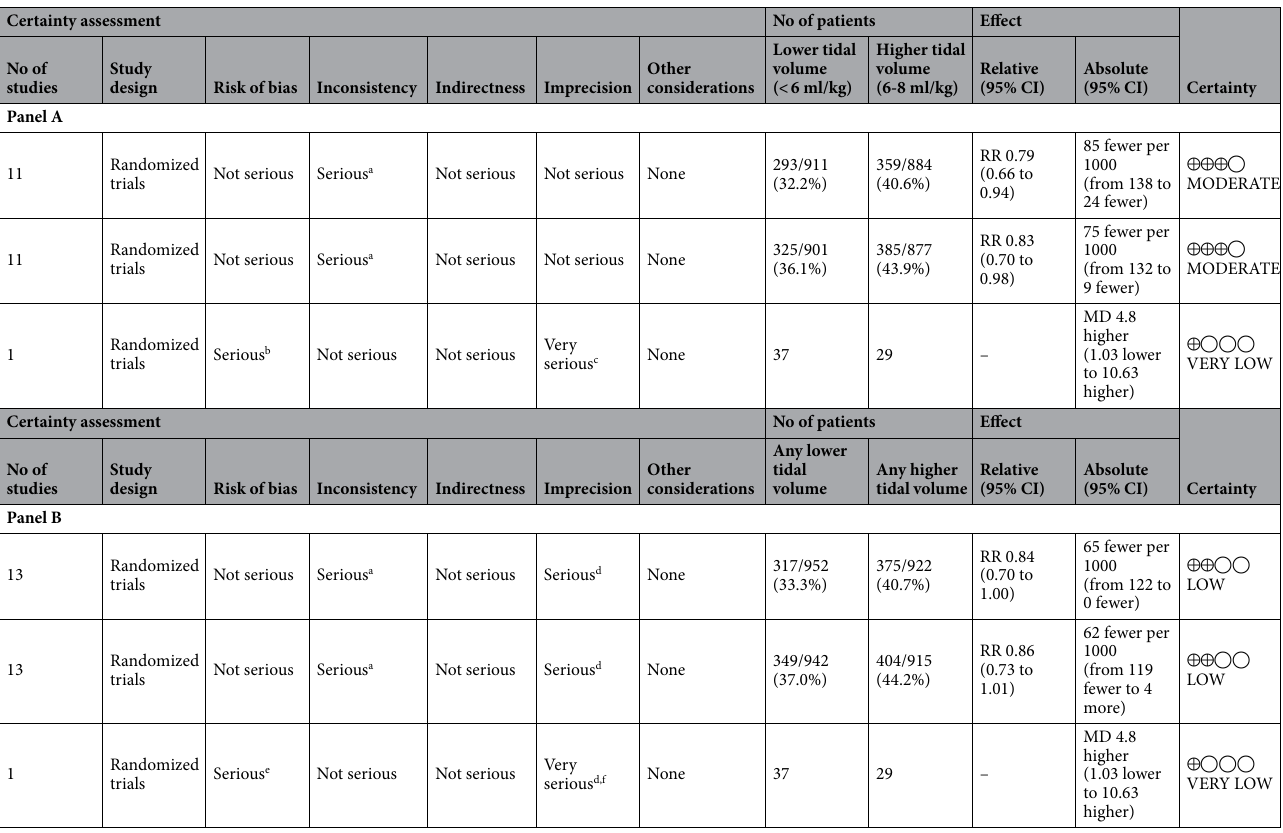
Table 2. Evidence tables of the systematic review. Comparison: (A) Lower tidal volume (6–8 ml/kg) compared to higher tidal volume (> 8 ml/kg) in patients with ARDS; (B) Any lower tidal volume compared to any higher tidal volume in patients with ARDS. CI Confidence interval, RR Risk ratio, MD Mean difference. a Different directions of effect in the study. b Most of the studies have a high risk of bias. c The wide confidence interval, sample size did not reach the Optimal Information Size. d The wide confidence interval. e Incomplete outcome data. f Unreached Optimal Information